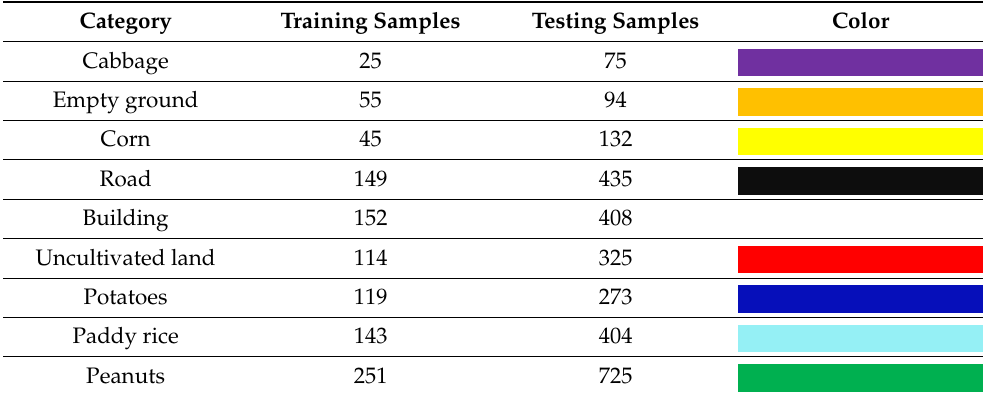
Table 1. Training samples and testing samples of labels and